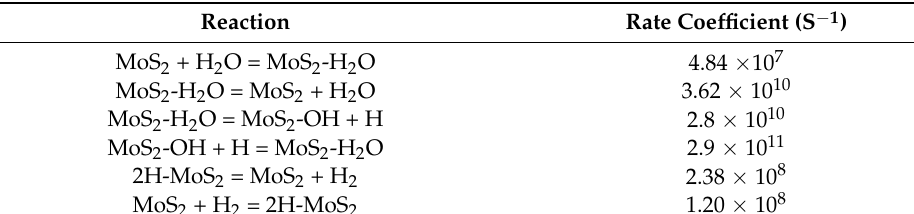
Table 3. Reaction scheme in kinetic Monte Carlo dynamics and rate coefficient.